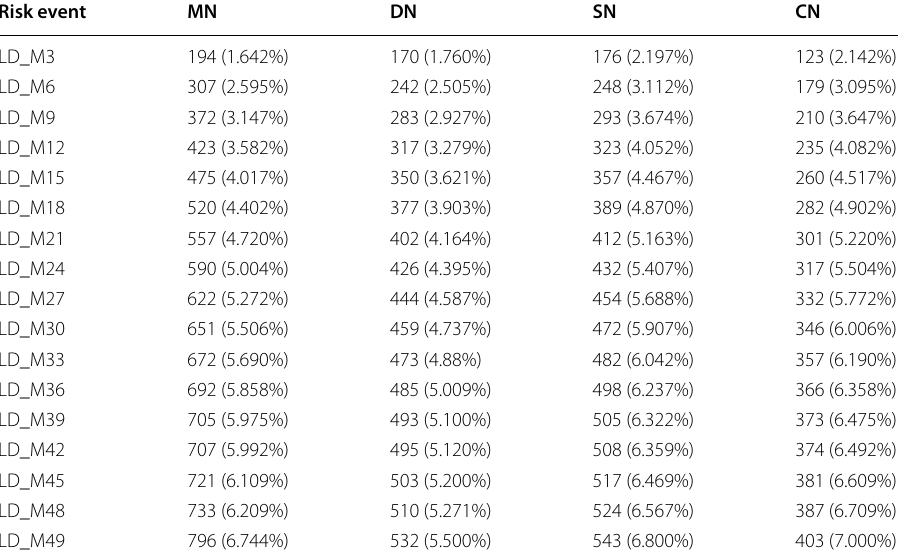
LD_M3 refers to loan disputes within 3 months. LD_M6 through LD_M48 are similar. LD_M49 refers to loan disputes in greater than 48 months